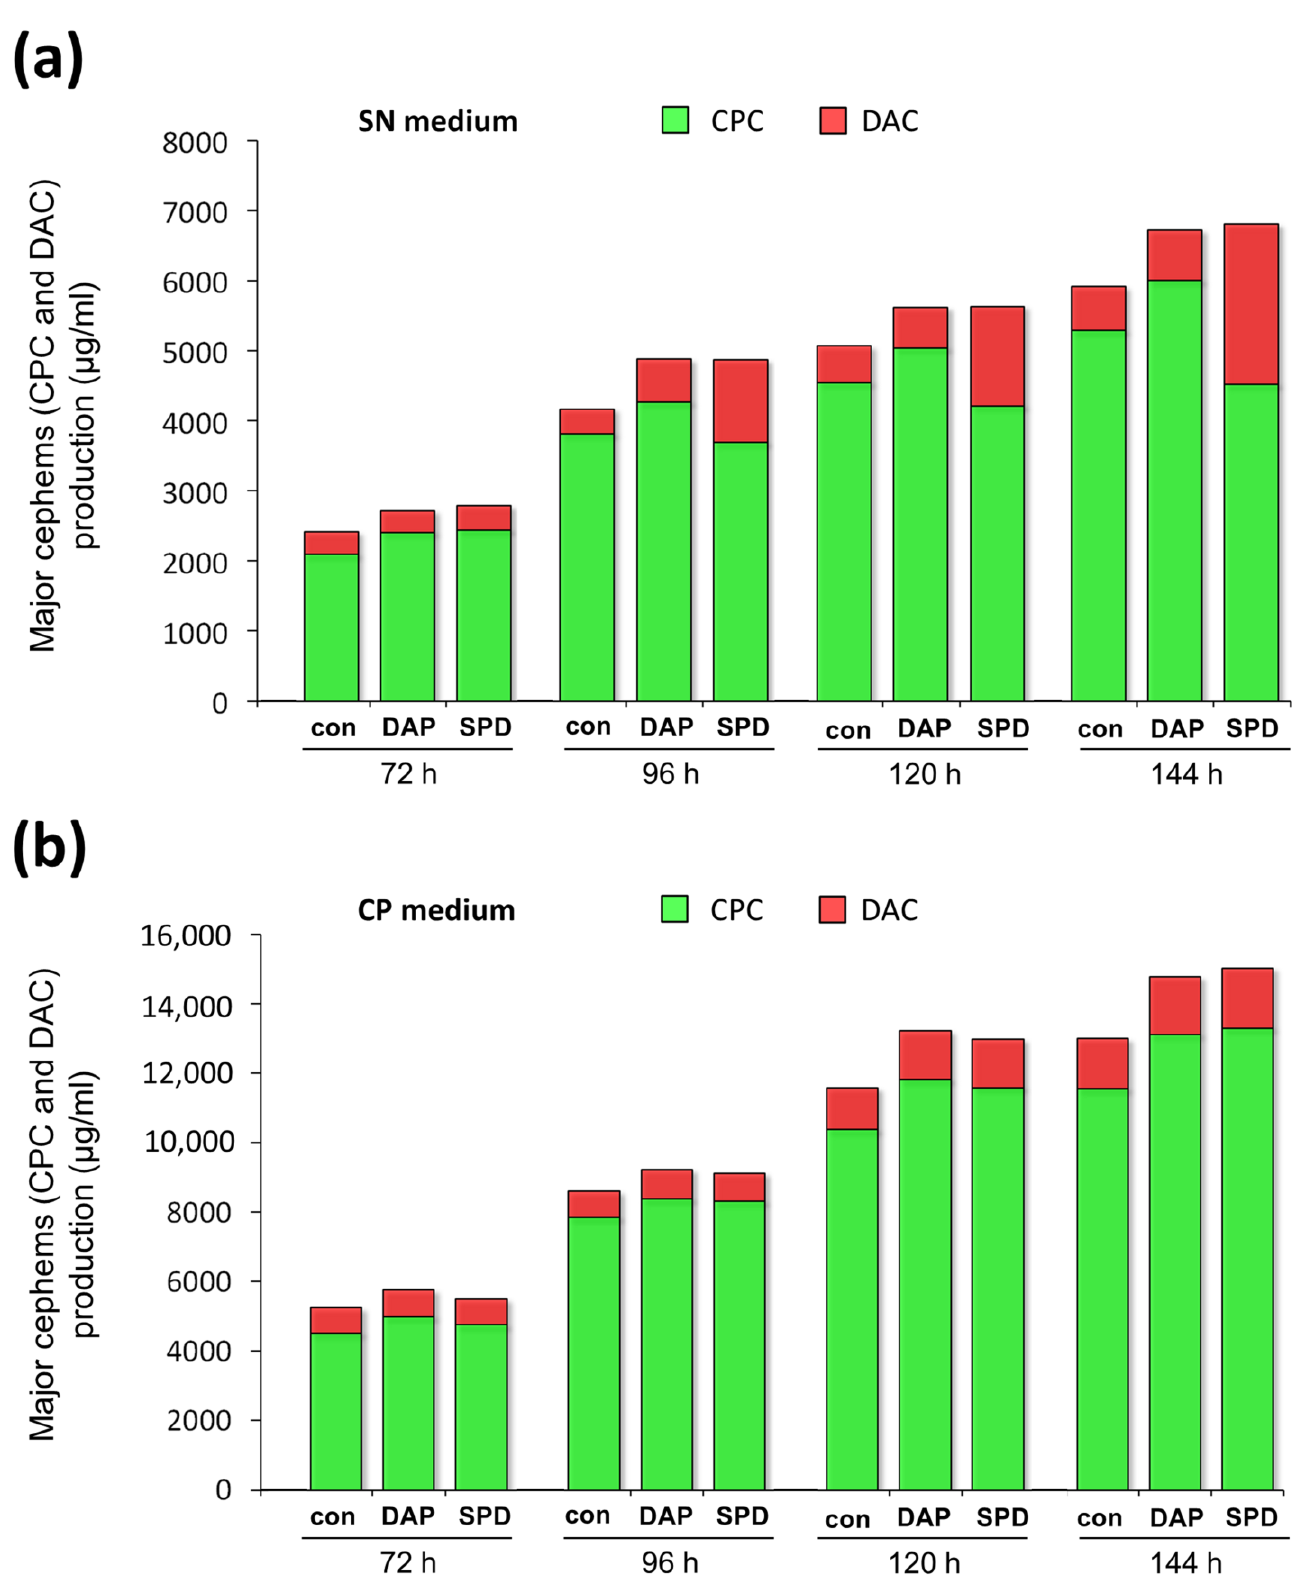
Figure 5. Effect of addition of 5 mM 1,3-diaminopropane (DAP) or 5 mM spermidine (SPD) on the production of cephems (DAC-deacetylcephalosporin C and CPC-cephalosporin C) by A. chrysogenum HY strain. Cultivation on: ( a ) synthetic (SN) medium; ( b ) complex (CP) medium. Samples were taken at 72 h, 96 h, 120 h, and 144 h. Data are means ± SD, n = 3.